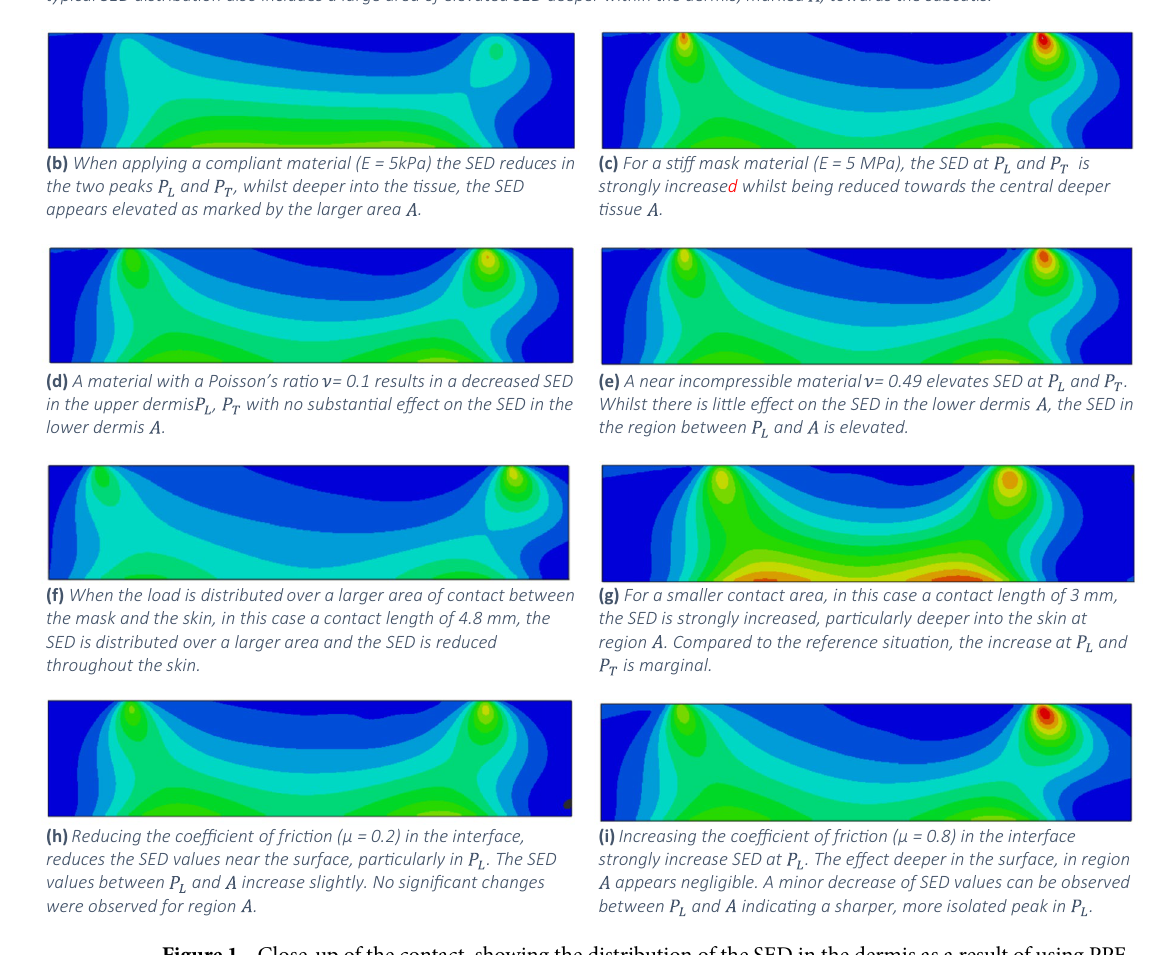
Figure 1. Close-up of the contact, showing the distribution of the SED in the dermis as a result of using PPE. Red indicates an elevated value. Distribution displayed overlayed over the undeformed tissue. Note that these images only show a portion of the skin, the used finite element model is larger, as shown in Fig.